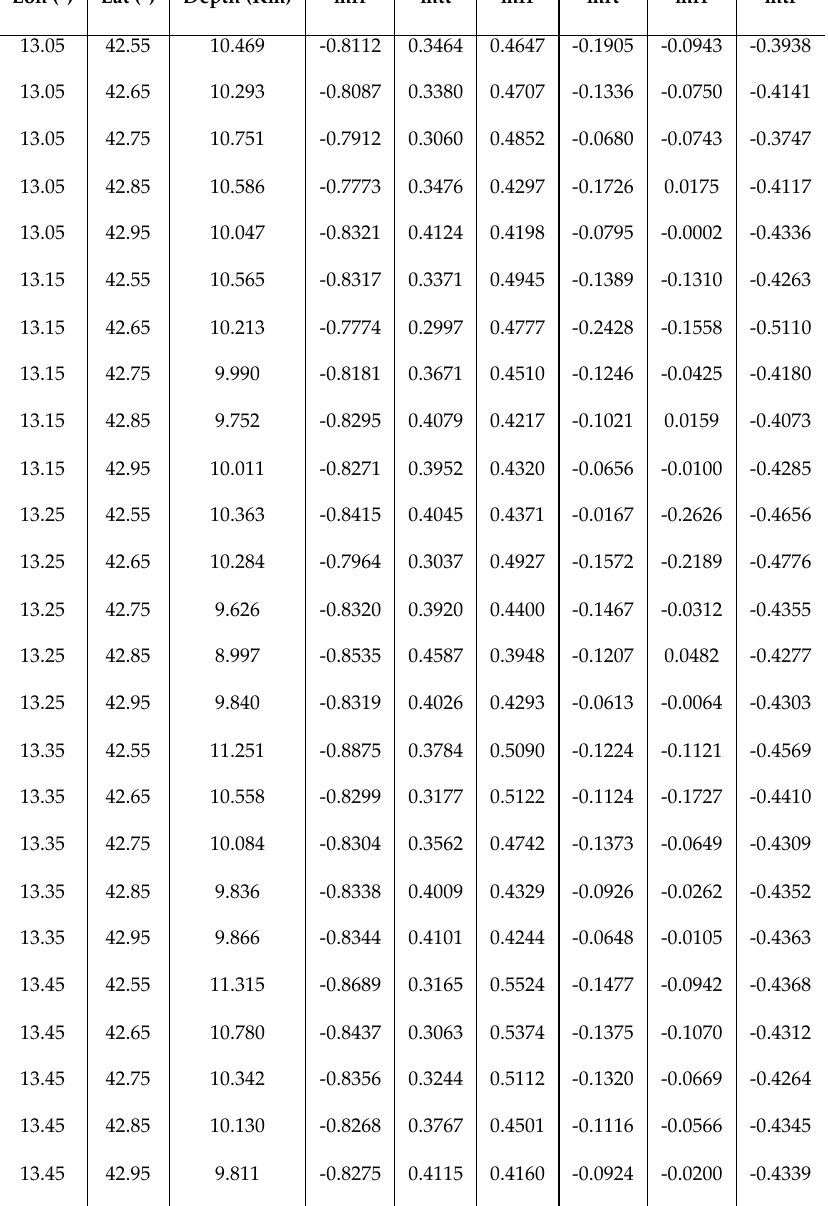
Table 1 : Seismic moment tensors obtained for each of 25 cells in Figure 2, for Normal Faulting focal mechanism type. Lon